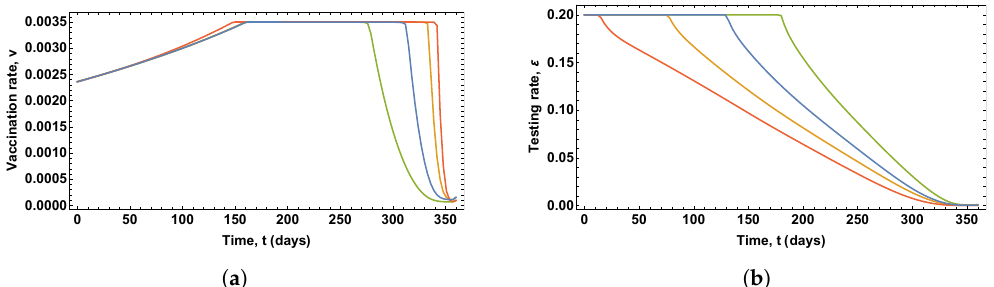
Figure 11. Optimal policies obtained assuming C 3 = 1 (red), C 3 = 0.1 (orange), C 3 = 0.01 (blue), and C 3 = 0.001 (green), with fixed parameters C 1 = 1 and C 2 = 0.1: ( a ) Optimal vaccination rates. ( b ) Optimal testing